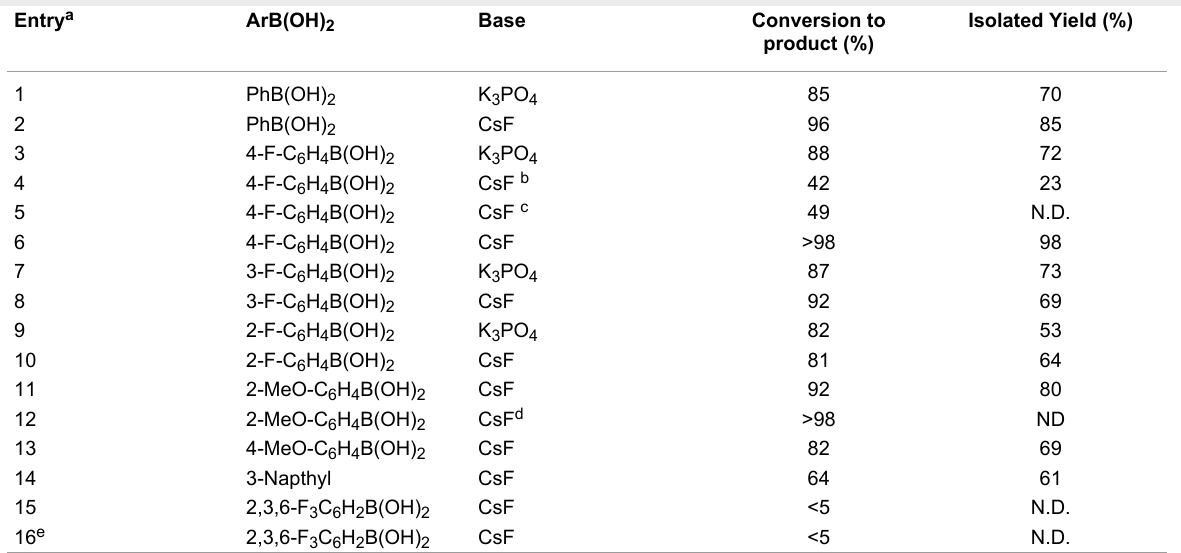
Table 1: Cross-coupling of a range of boronic acids with 4-chloroacetophenone. Entry a